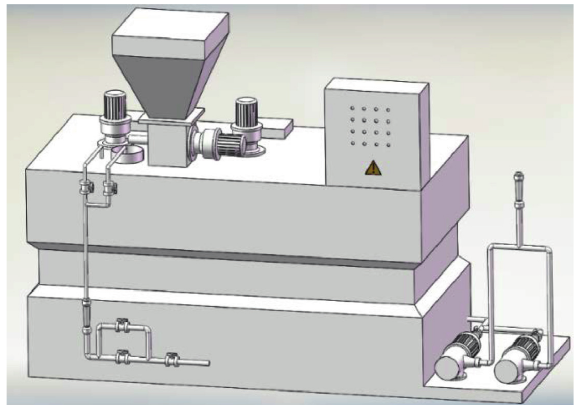
Figure 5: Model of flocculant automatic dosing machine.